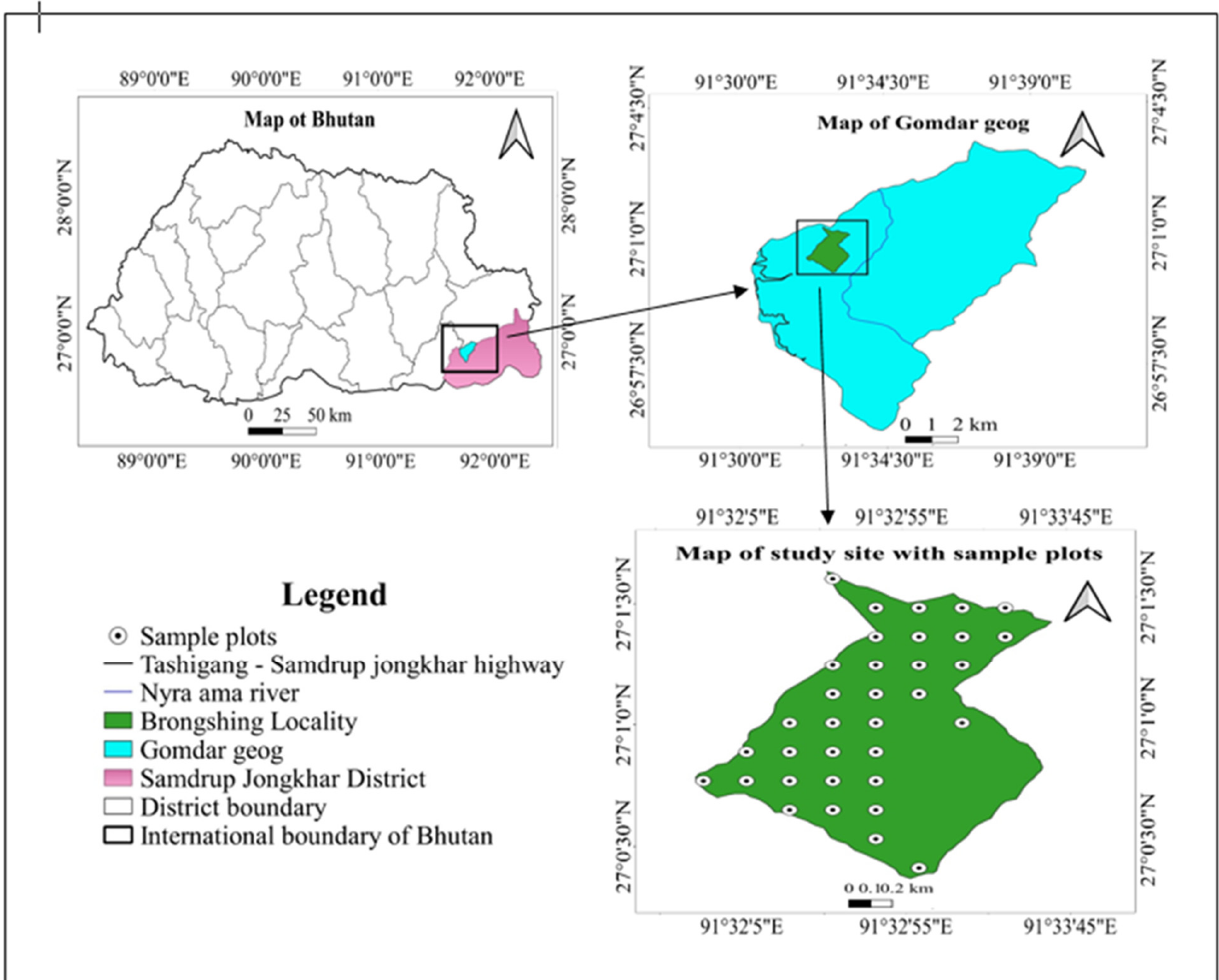
Figure 1. Map of the study